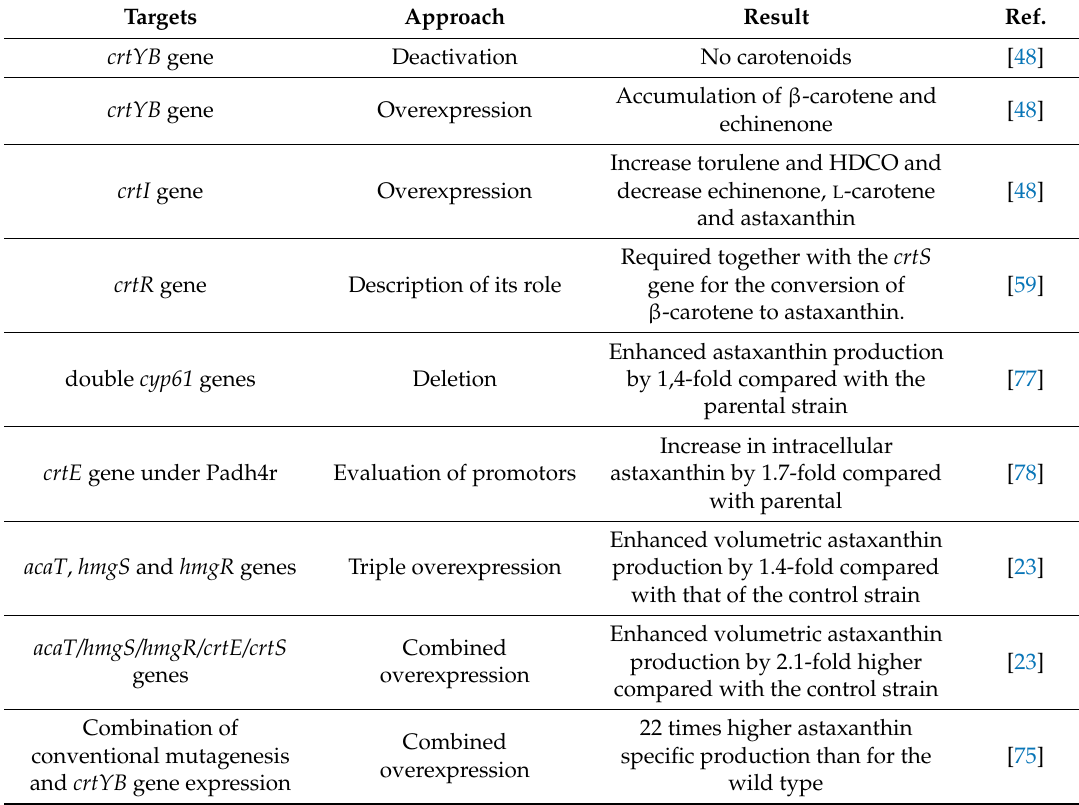
Table 1. Examples summary of X. dendrorhous ( P. rhodozyma ) genetic engineering.